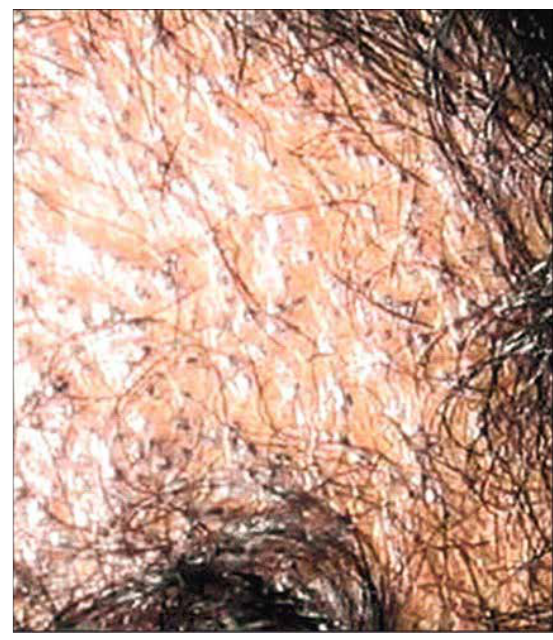
Figure 3: “Black dot tinea capitis” (Image available from http://pedsinreview.aappublications.org/ content/33/4/e22)